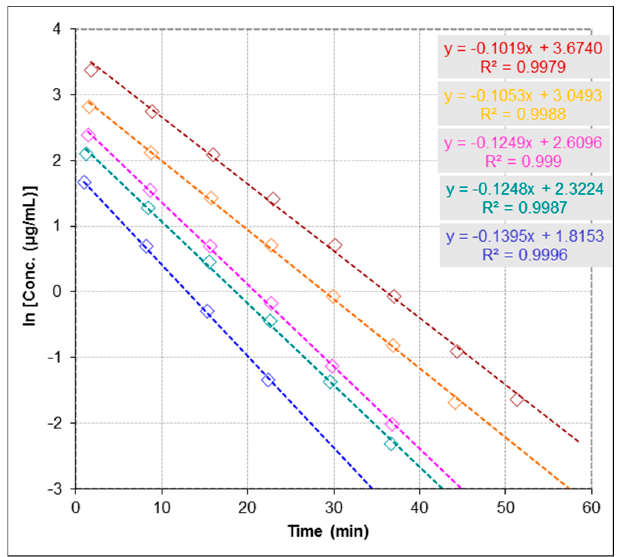
Figure 2. Urease-catalyzed reaction evaluated by Electrospray Ionization-Mass Spectrometry (ESI- MS) based assay at five concentrations of urea as shown in the figure 137.0 [ ● ], 208.2 [ ● ], 274.0 [ ● ], 416.4 [ ● ] and 694.1 [ ● ] µmol ∙ L − 1 and fixed concentration of urease 60.0 µg ∙ mL − 1 by monitoring catalytic reaction through simultaneous detection of the concentration changes of urea, where the slopes represent the reaction rate constants (k 0 ) in the absence of inhibitors. Concentrations changes of urea are presented as logarithms of concentration. The precision of time course analysis was calculated as RSD (%) of multiple measured slopes (lower than 10%). For clarity of figure, multiple measurements have not been presented.